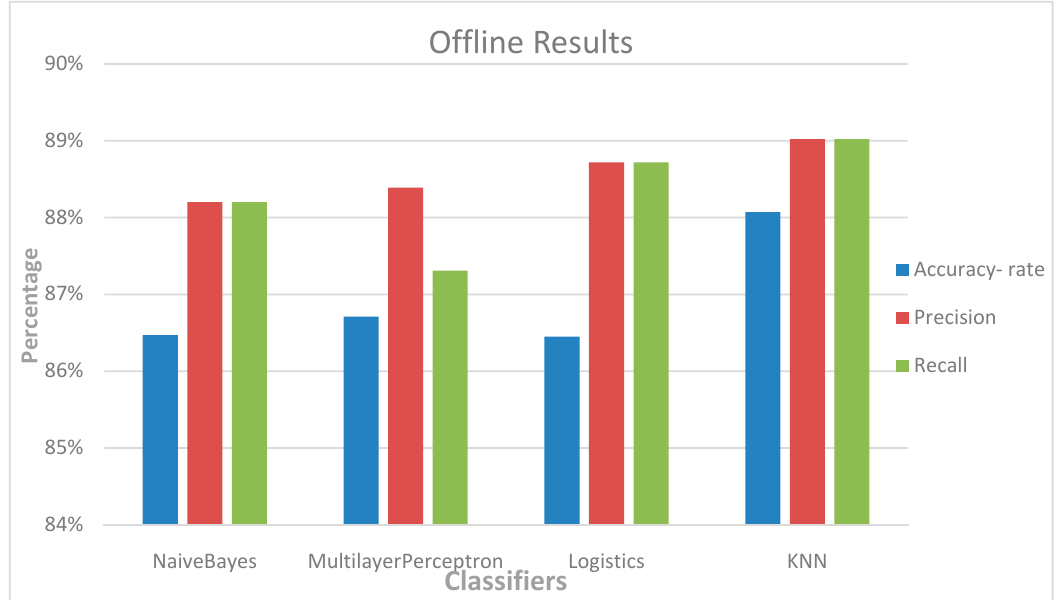
Figure 6. System interaction between different modules. Energies 2020 , 13 , x FOR PEER REVIEW